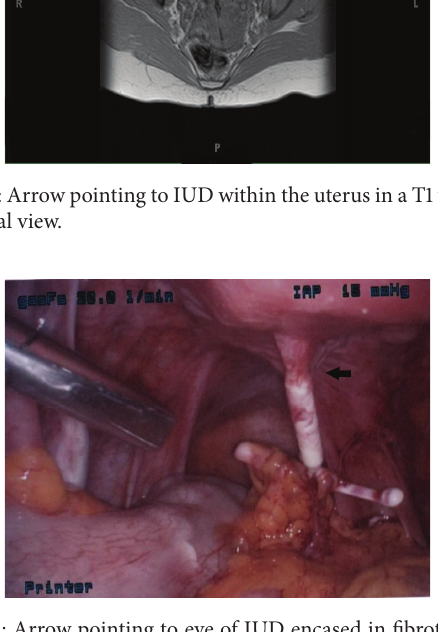
Figure 2: Arrow pointing to eye of IUD encased in fibrotic tissue. Arms of IUD covered in adhesions stemming from mesenteric adipose.